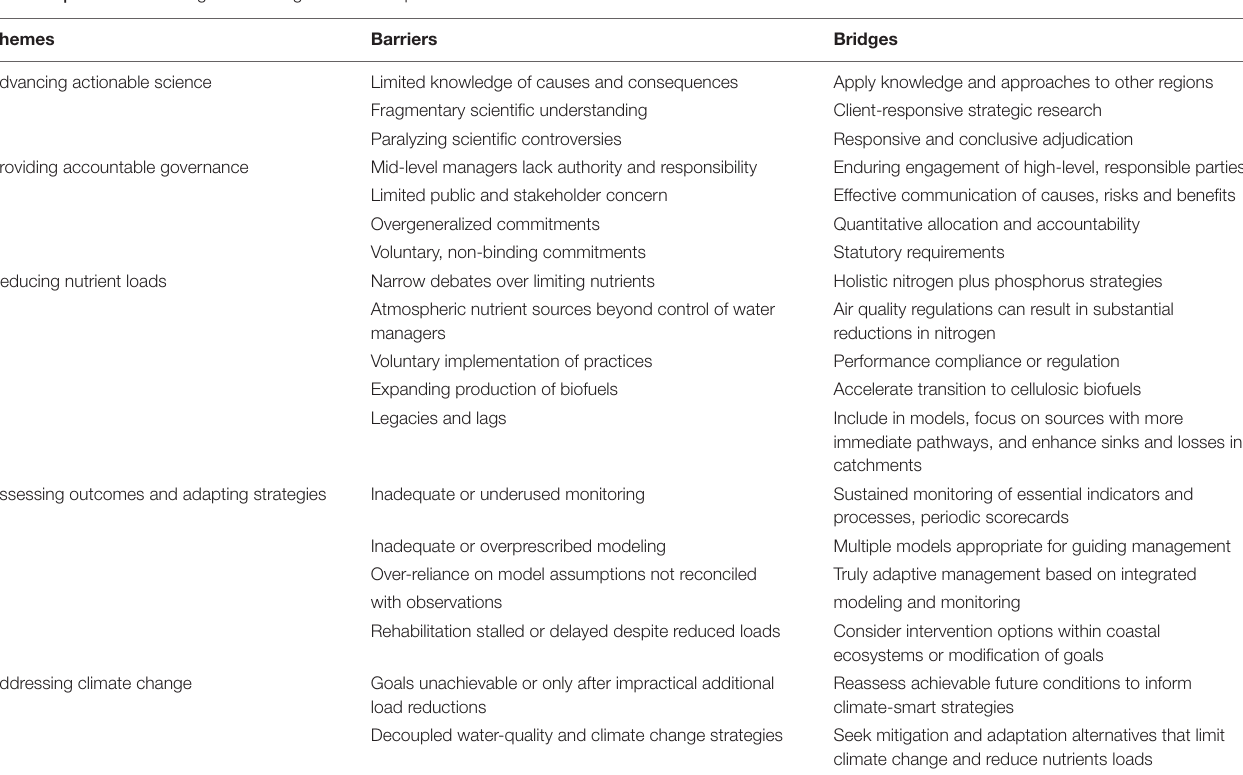
FIGURE 1 | Location of major campaigns to abate coastal eutrophication discussed in this paper. Size of the circles is roughly proportional to the area affected by eutrophication. TABLE 1 | Barriers and bridges in abating coastal